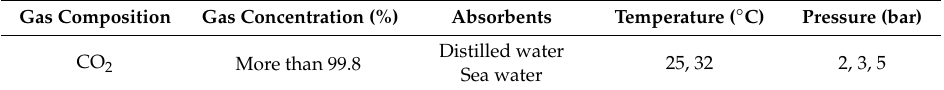
Table 1. Conditions of absorption experiments.